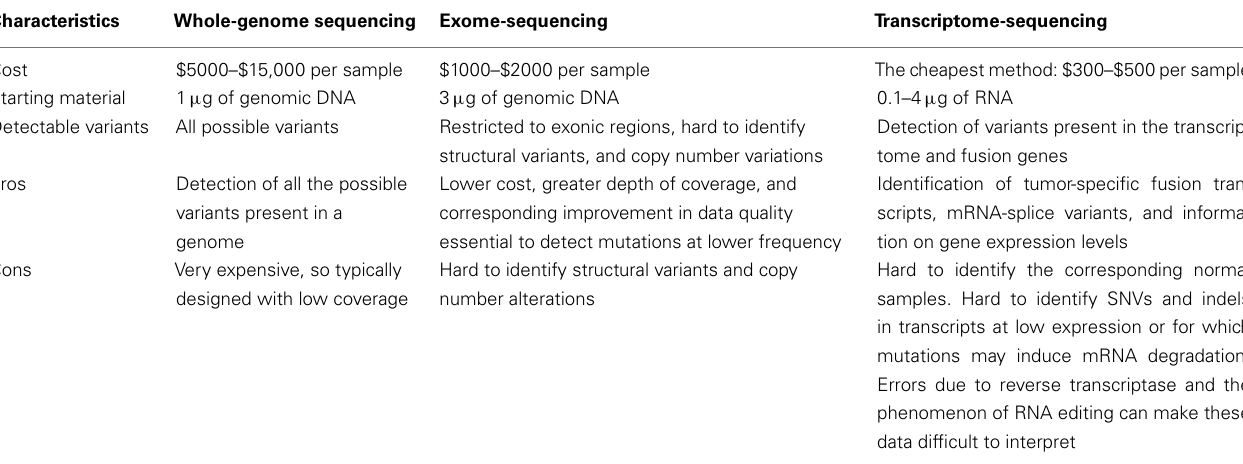
Table 3 | Comparison of pros and cons of whole-genome sequencing, exome-sequencing, and RNA-sequencing.